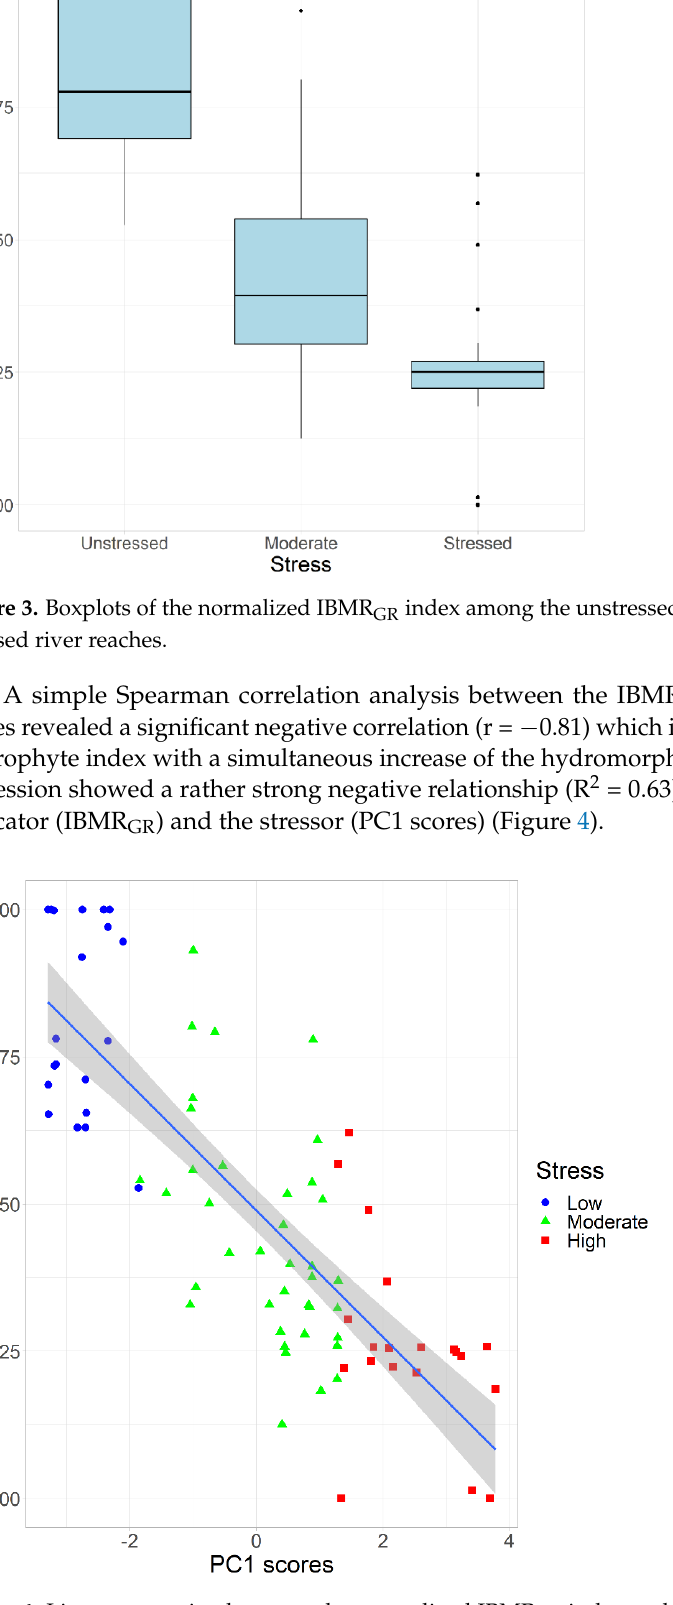
Figure 4. Linear regression between the normalized IBMR GR index and the scores of PC1. Higher PC1 values indicate higher levels of stress. Shaded area represents the 95% confidence intervals.